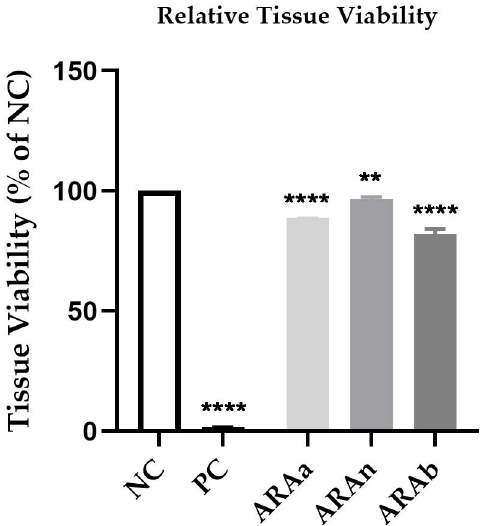
Figure 6. Morphology and confluence of HaCaT cells following the 24 h stimulation with ARA suspended in acidic, neutral, and basic artificial saliva. The highest (1:16) and the lowest (1:1) dilutions were selected for this evaluation. The scale bars represent 100 µm.